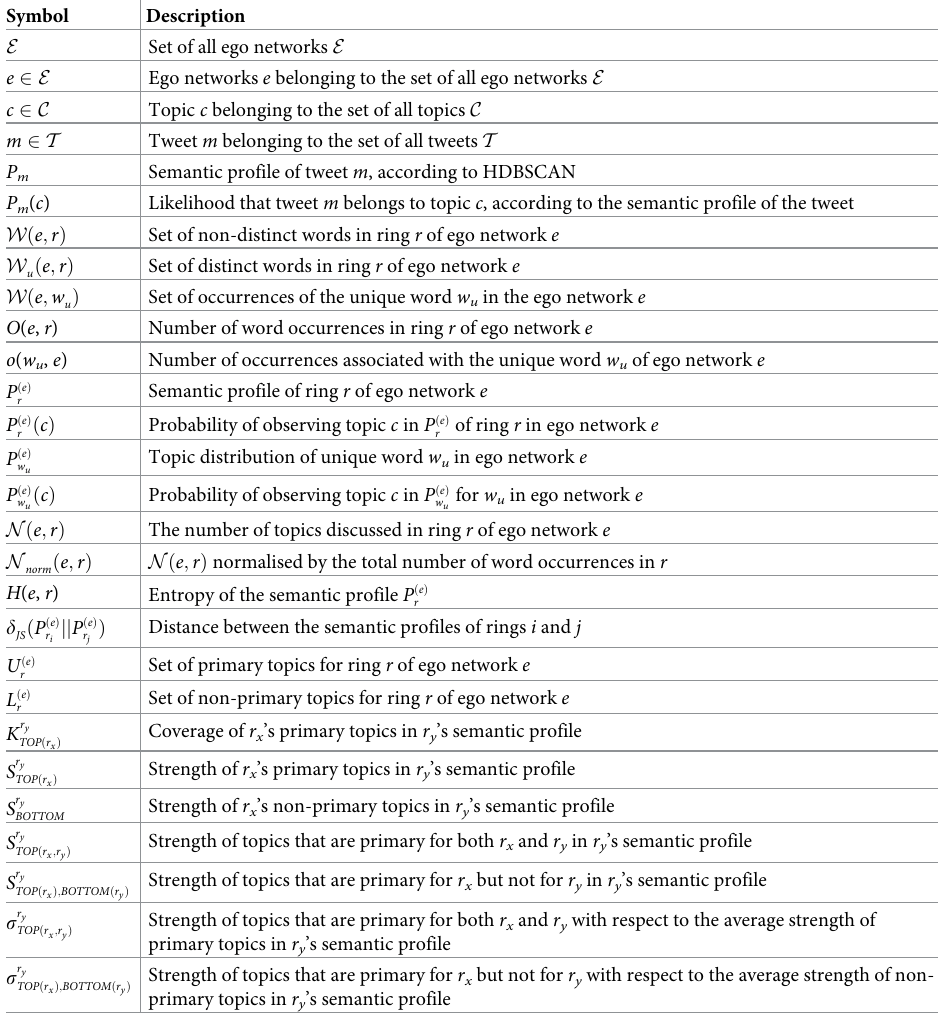
Table 4. Summary of the notation used in the semantic